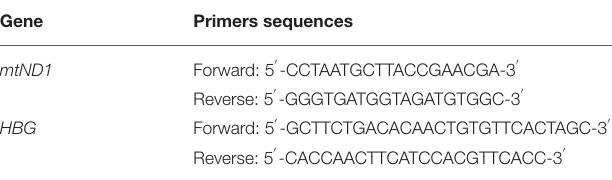
TABLE 1 | Primers sequences for Real-time